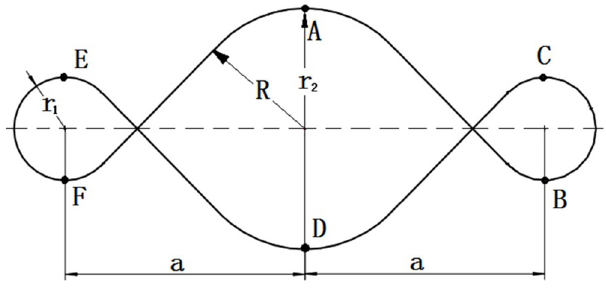
Fig. 2. Trajectory of